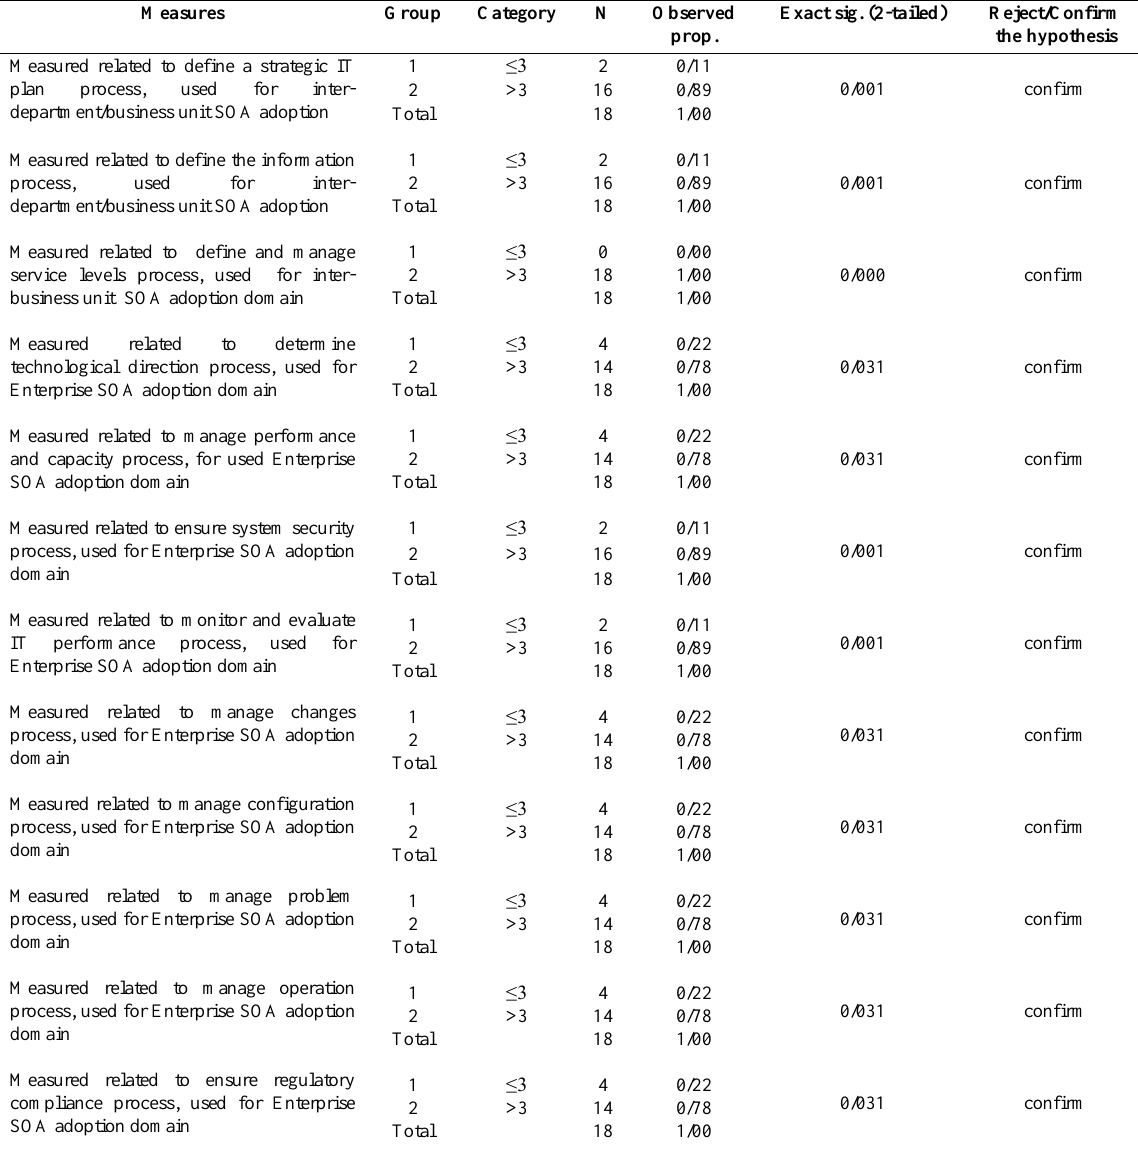
Table 7: Result of testing hypothesis of A section (sig. level